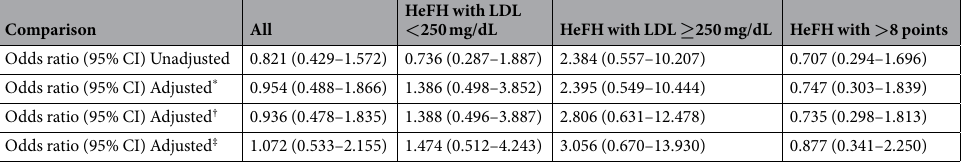
Table 6. Effect of phenotype severity in heterozygous familial hypercholesterolemia on type 2 diabetes prevalence. * Adjusted for age, sex and years of statin use. † Adjusted for age, sex, years of statin use and